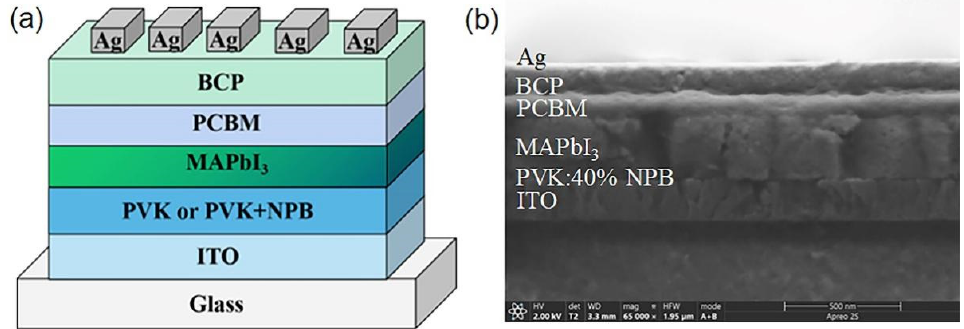
Figure 1. The schematic diagram of device structure ( a ) and cross-sectional SEM image ( b ) of PSC.